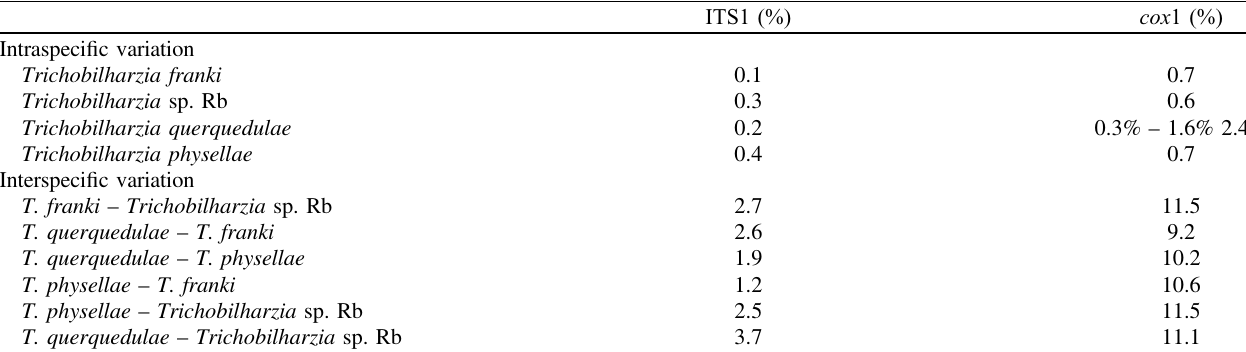
Table 5. Average pairwise uncorrected p- distances among taxa in the phylogenetic